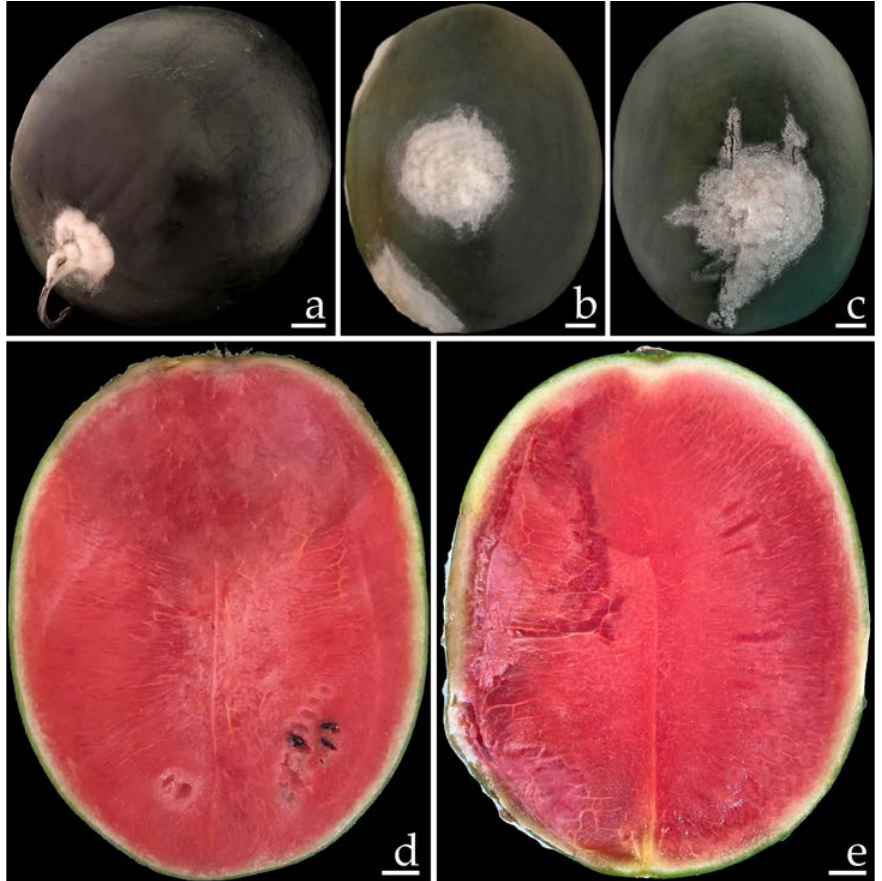
Figure 1. Naturally occurring symptoms of fruit rot in watermelon ( a ‒ c ). A cross section of the in- fected watermelon fruits shows the internal decaying areas ( d , e ). Scale bars: ( a ) = 30 mm; ( b , c ) = 20 mm; ( d , e ) = 15 mm.